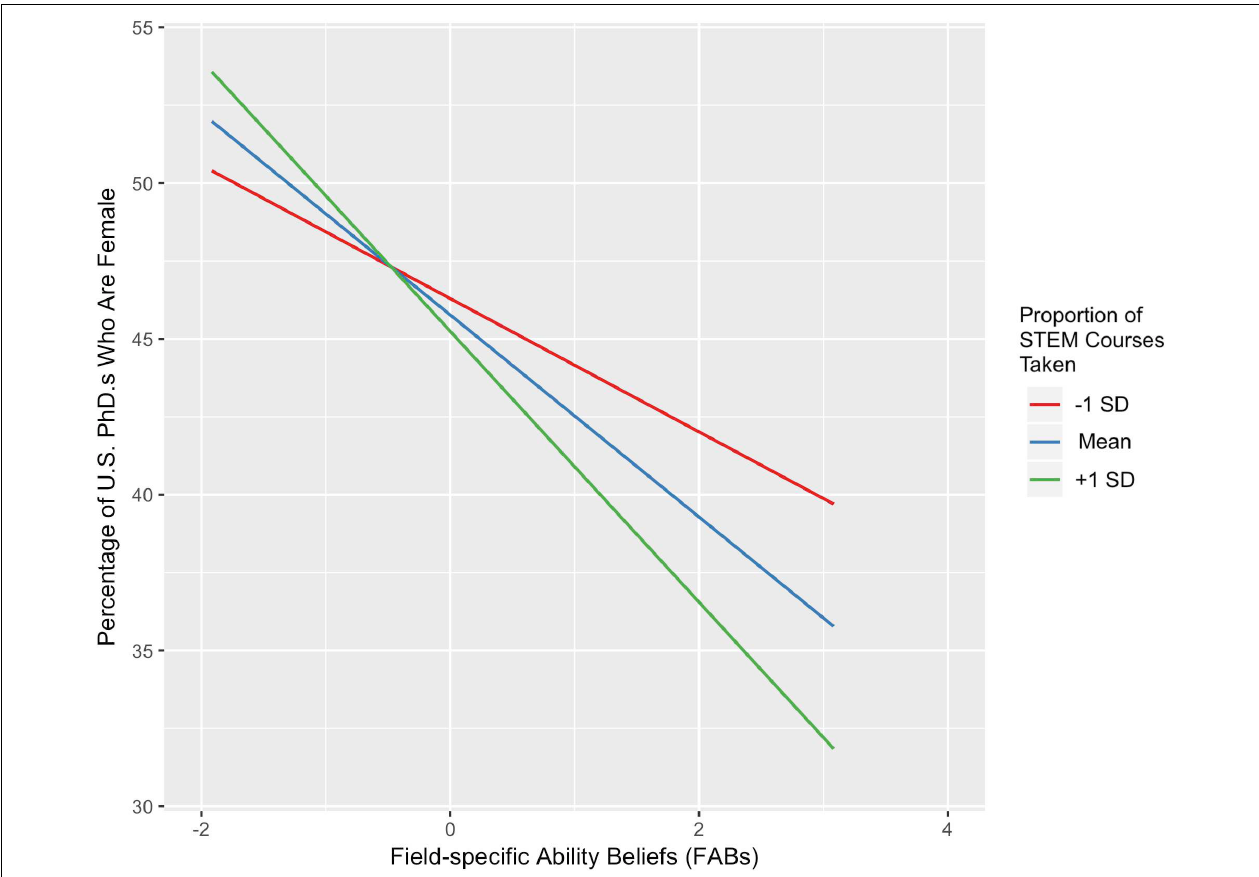
FIGURE 2 | The relationship between beliefs about the necessity of brilliance for success in a field and the percent of women in that field, operationalized as percent of women earning Ph.D’s in 2011. Both subjects and field are random effects. The green and red lines represent the predicted slope for students 1 standard deviation above and below the mean in proportion of pSTEM courses taken, respectively; the blue line depicts the predicted slope for students at the mean of proportion of pSTEM courses taken. FABs is